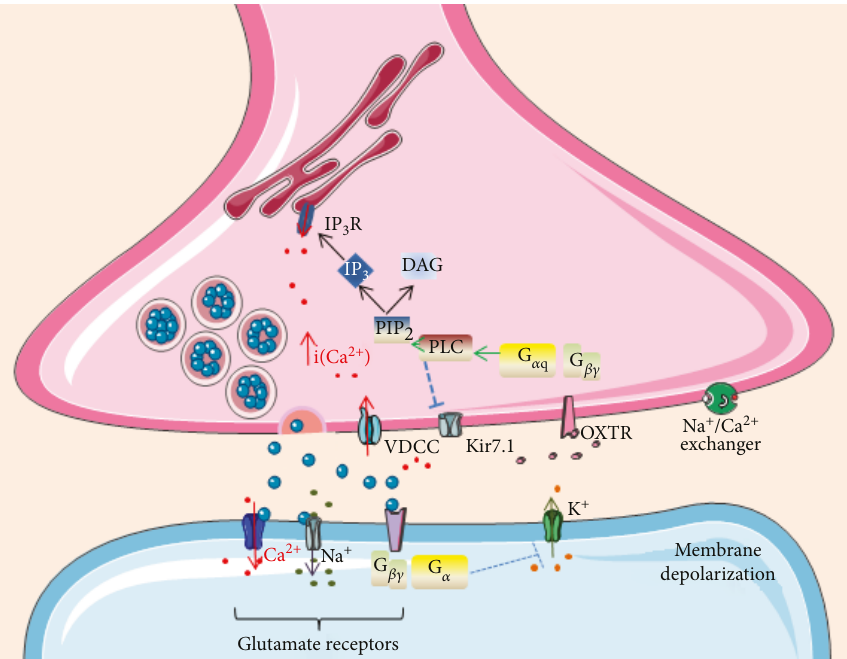
Figure 1: Presynaptic G protein-coupled oxytocin receptors modulate membrane polarity. OXTR: oxytocin receptor; VDCC: voltage- dependent calcium channels; PIP : phosphatidylinositol biphosphate; IP : inositol 1,4,5-trisphosphate; DAG: 2 3